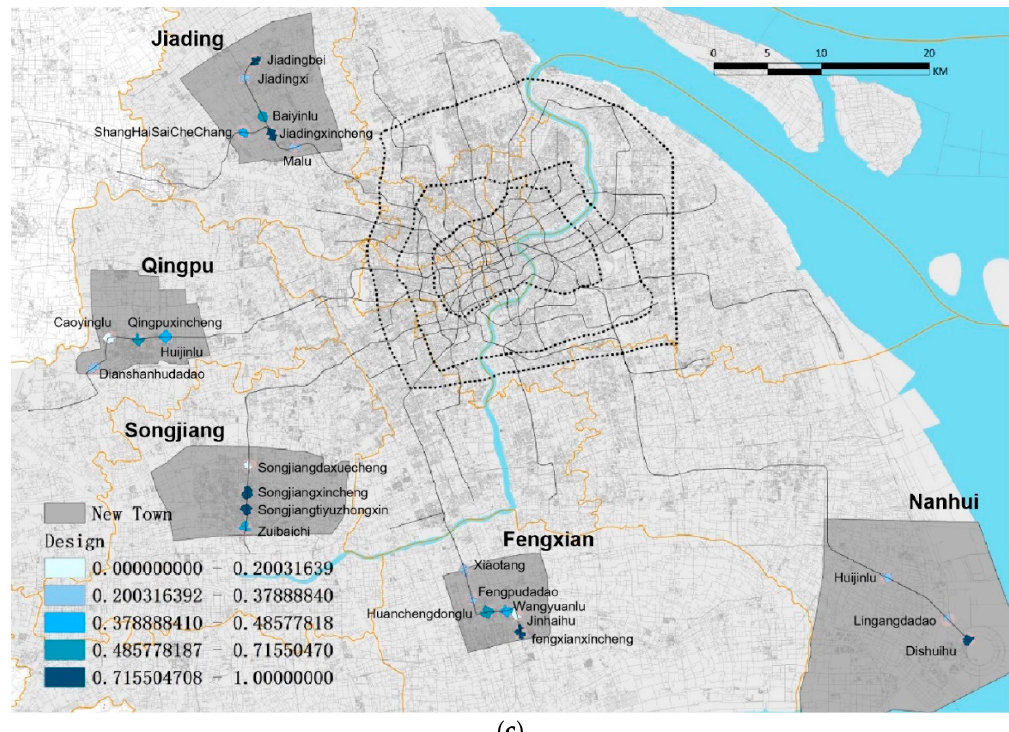
Figure 8. The spatial distribution of metro stations regarding Node, Place, and Design indices. ( a ): The spatial distribution of metro stations regarding the Node index. ( b ): The spatial distribution of metro stations regarding the Place index. ( c ): The spatial distribution of metro stations regarding the Design index.